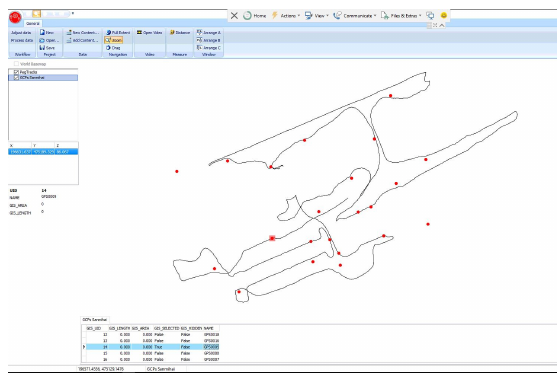
Figure 15. View GCP checkpoints.